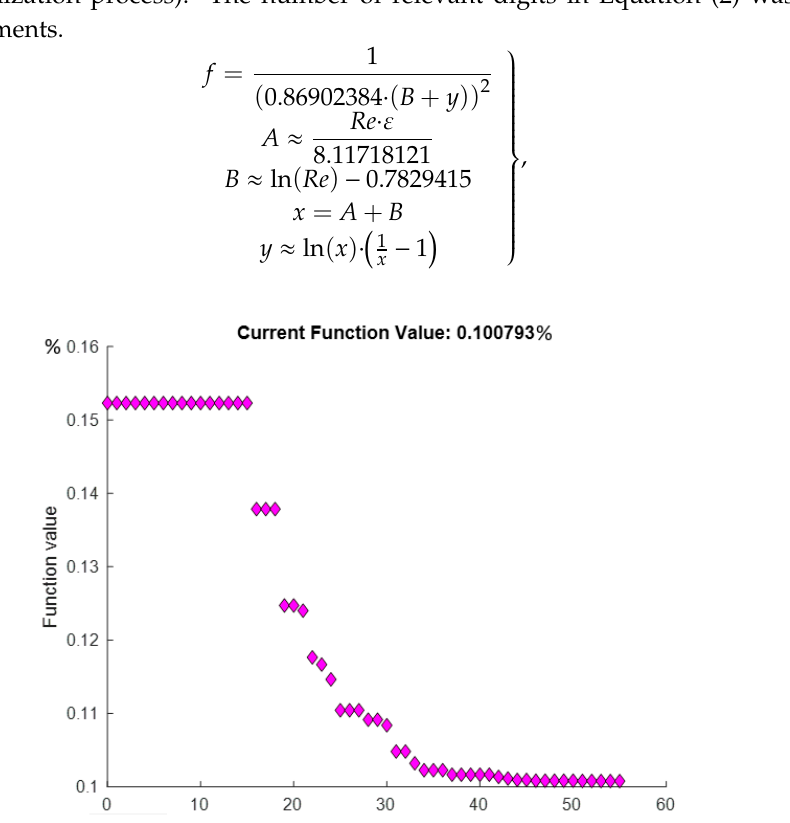
Figure 1. Reduction of the maximal relative error during the optimization process for Equation (3) of [1]. The optimized formula is given in Equation (2).